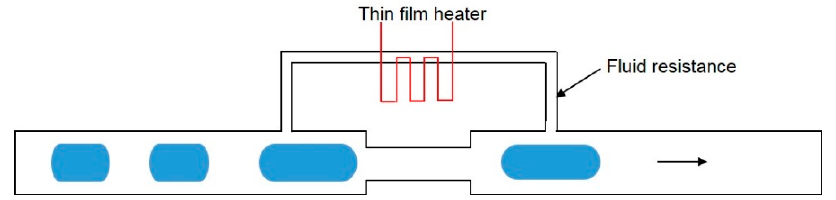
Figure 18. Schematic illustration of thermally controlled droplet coalescence microfluidic device.